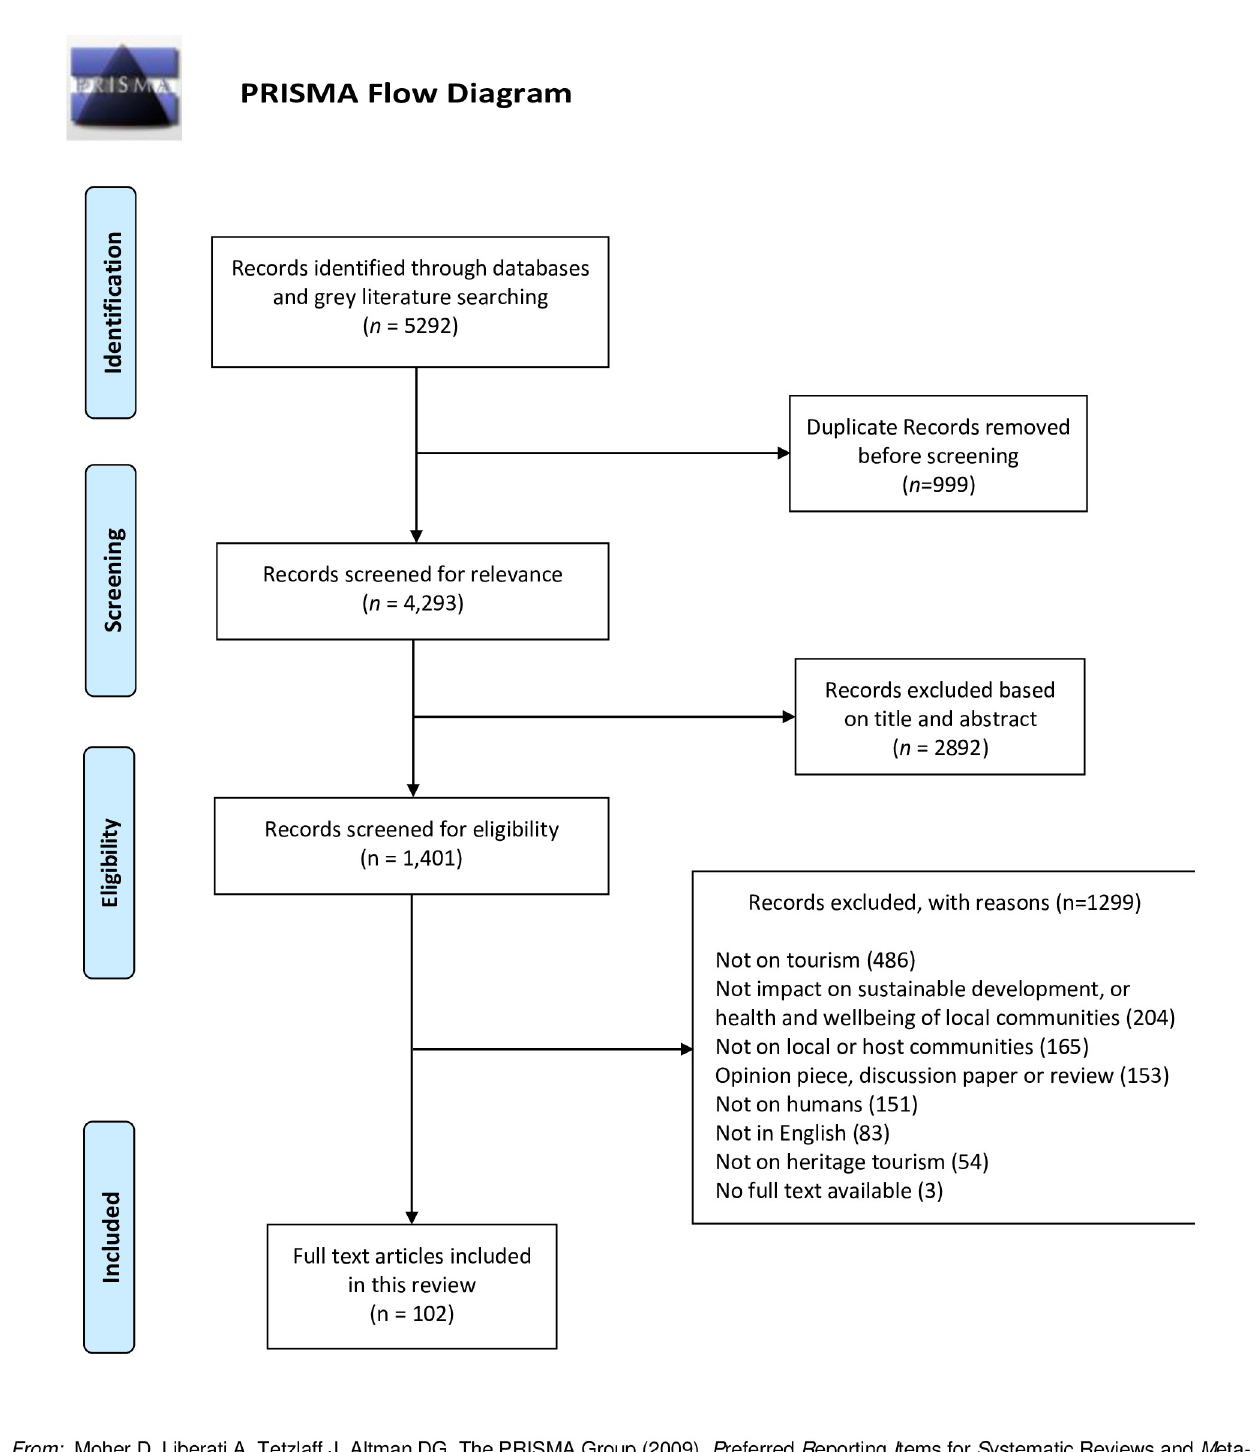
Fig 1. PRISMA diagram and flow chart.